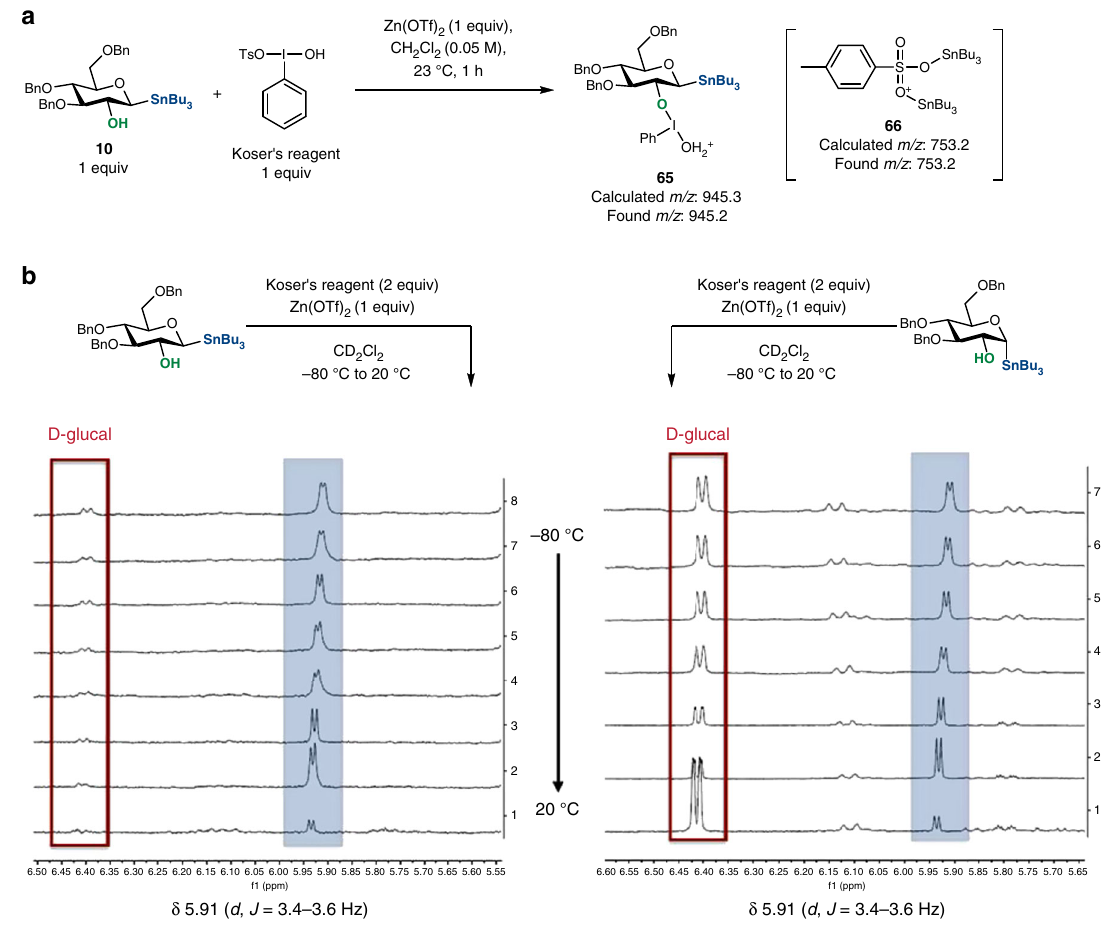
Fig. 5 Mechanistic investigations. a Reaction of stannane 10 with Koser ’ s reagent. b 1 H NMR spectra of reaction mixtures of α - and β -stannanes and Koser ’ s reagent